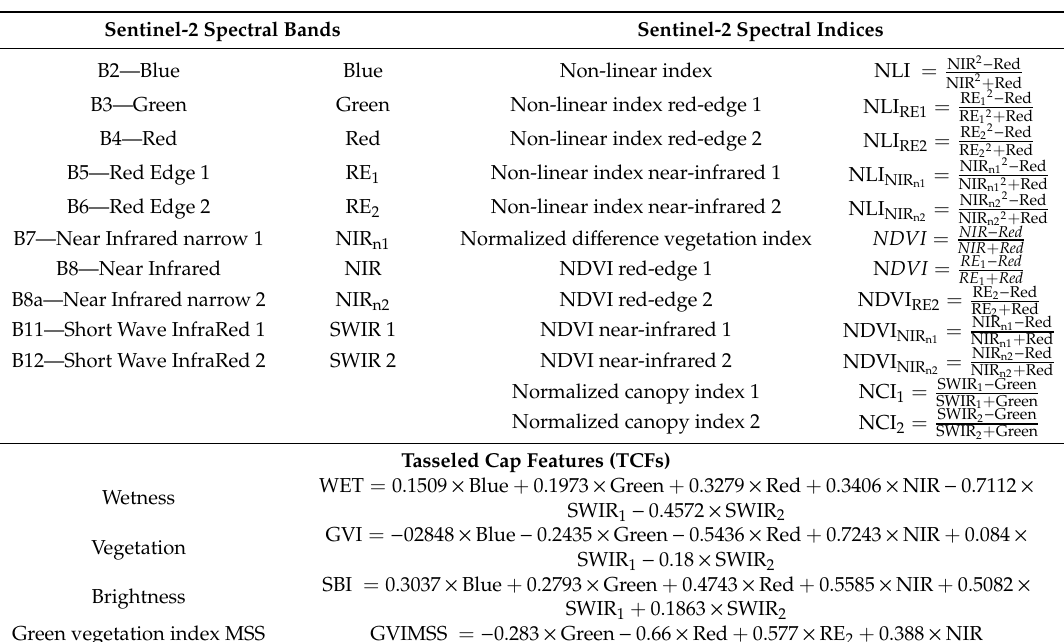
Table 1. Spectral Variables used in the present